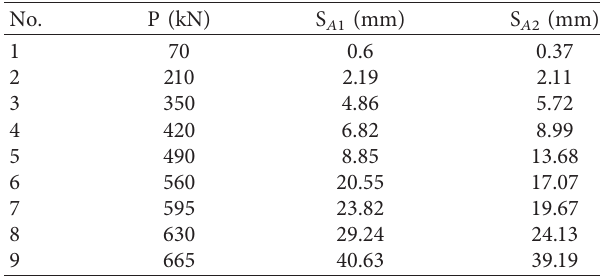
Table 1: Pullout test results from example 1.